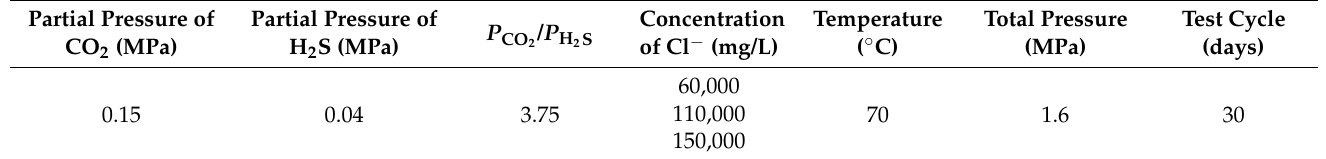
Table 5. Experimental conditions